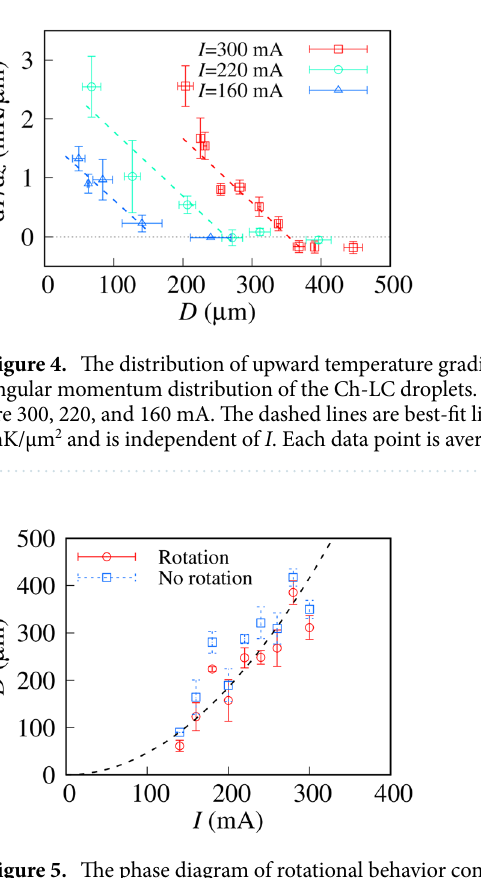
Figure 5. The phase diagram of rotational behavior concerning I and D . To distinguish between rotation and no rotation, we observed the rotational behavior of Ch-LC droplets for a long time (> 5 min). The boundary between regions of rotation and no rotation are indicated by a dashed line. Ch-LC droplets can detect micro- temperature gradient generated from the Au thin-film electrode in the region above the dashed